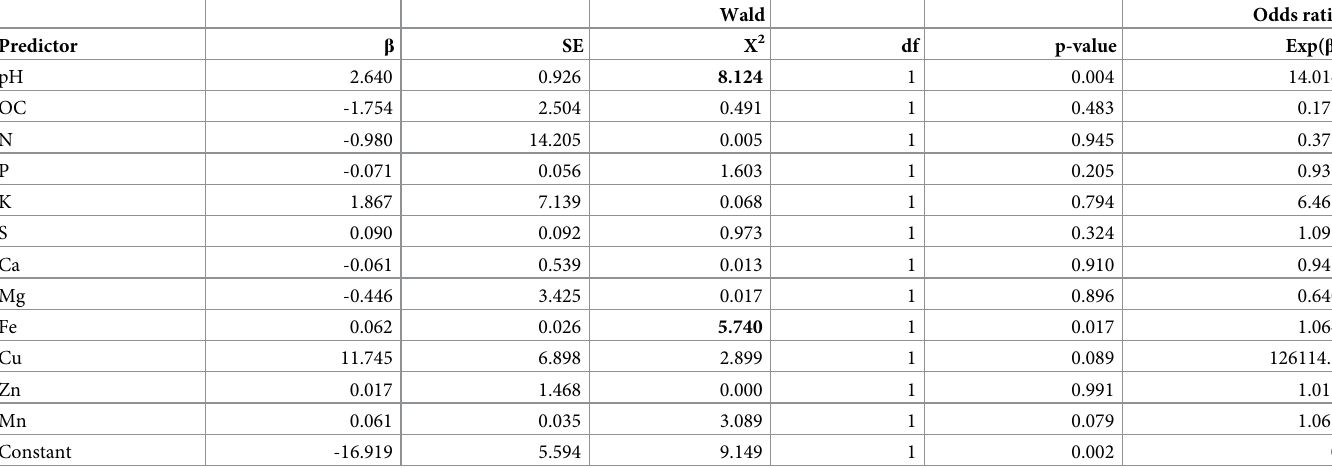
Wald Odds ratio